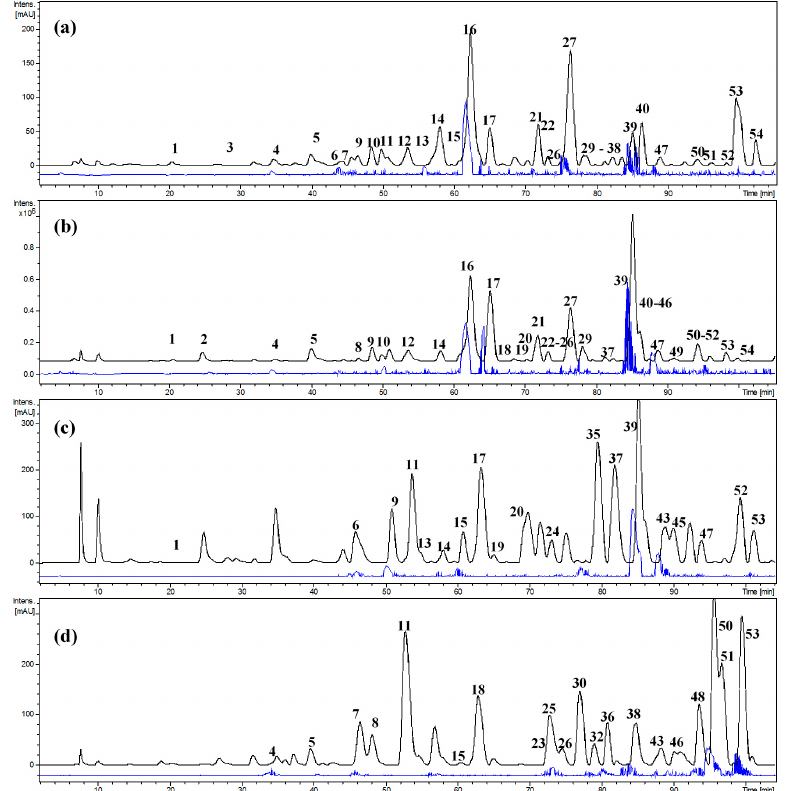
Figure 2. HPLC profile (280 nm, black) and total ion chromatogram (blue) of the polyphenolic-enriched extracts of G. decorticans frutis from: ( a ) Alto del Carmen; ( b ) Copiapó (ripe); ( c ) Sephadex fractions 20–25; ( d ) Sephadex fractions 28–30.